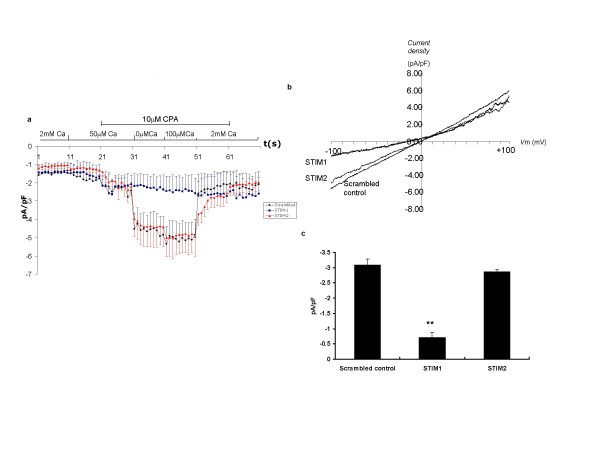
Reduced SOC activated inward current in STIM1 suppressed cells compared with control and STIM2 suppressed cells assessed by whole cell patch clamp. (a) A time course of current density (measured at -100 mV), each point represents mean data ± sem of all cells in each group; control cells treated with scrambled siRNA (black circles, n = 16), STIM1 suppressed cells (blue squares, n = 10) and STIM2 suppressed cells (red triangles, n = 12). (b) Current-voltage (I-V) relationships at the steady-state SOC current (ie addition of 10 μM CPA in nominally Ca2+ free buffer) and represents averaged data from all cells of each experimental group. (c) A bar chart illustrating peak CPA sensitive current density (measured at -100 mV) of cells treated with scrambled control, STIM-1 or STIM-2 siRNA. Data are indicated as statistically significant with **P < 0.01.